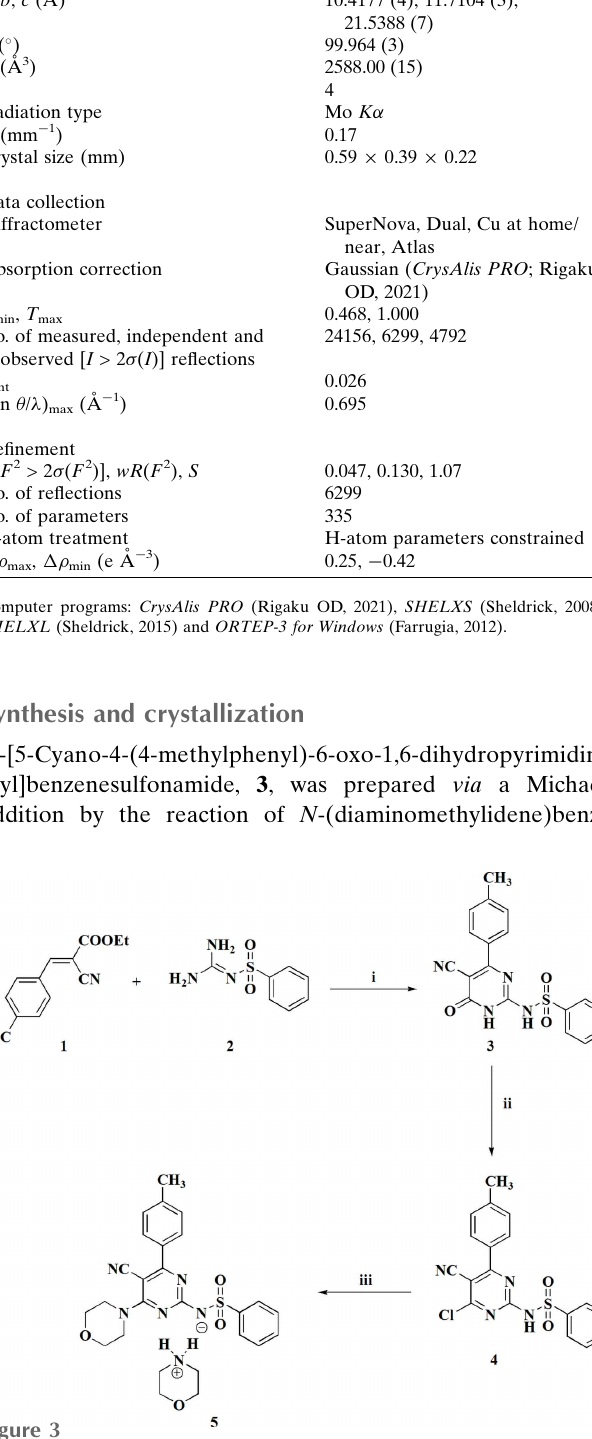
Figure 2 A segment of the crystal structure showing a tetramer of two anions and two cations with hydrogen bonds shown as red dashed lines.